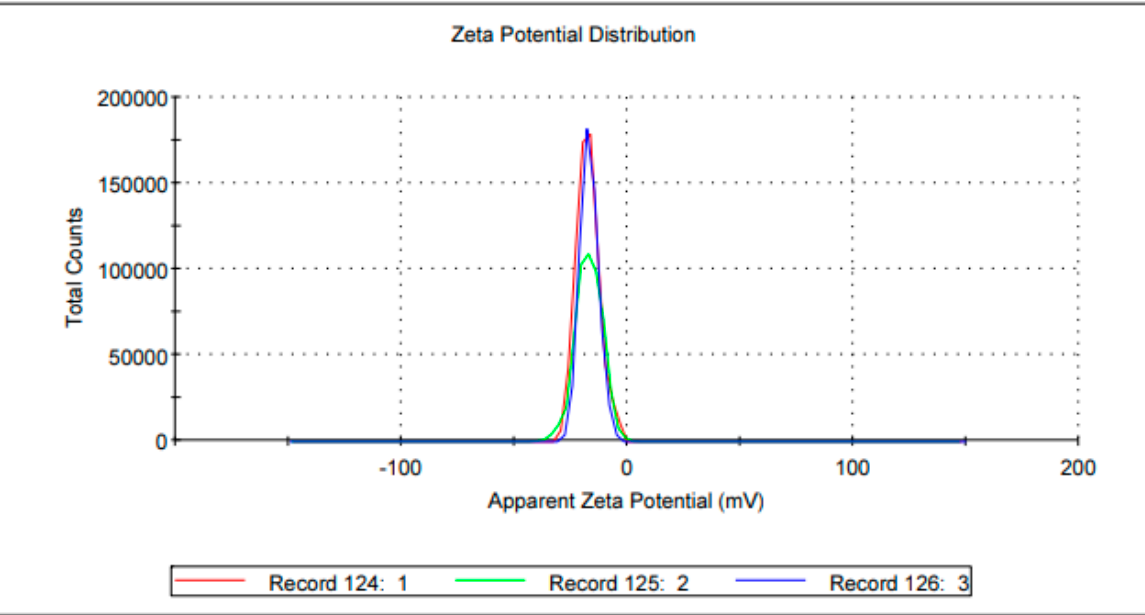
Figure 3. Zeta potential of AgNPs prepared with aqueous A. nilotica pod extract.